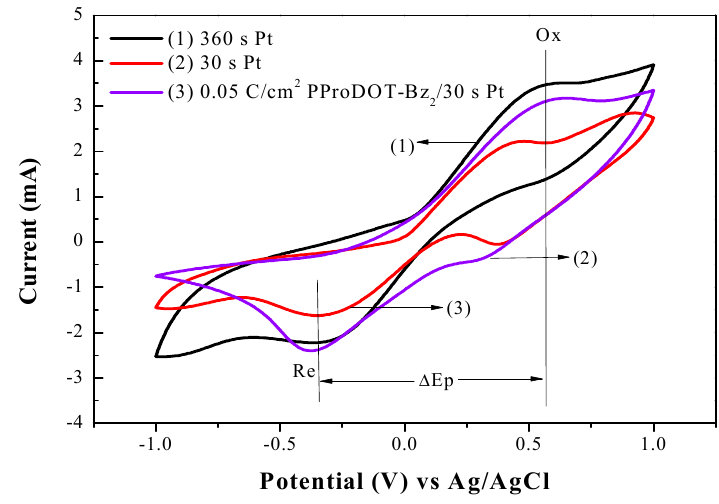
Figure 5. Cyclic voltammetry of the various counter electrodes at a scan rate of 100 mV s − 1 in acetonitrile solution containing 0.1 M LiClO 4 , 10 mM LiI, and 1 mM I 2 .